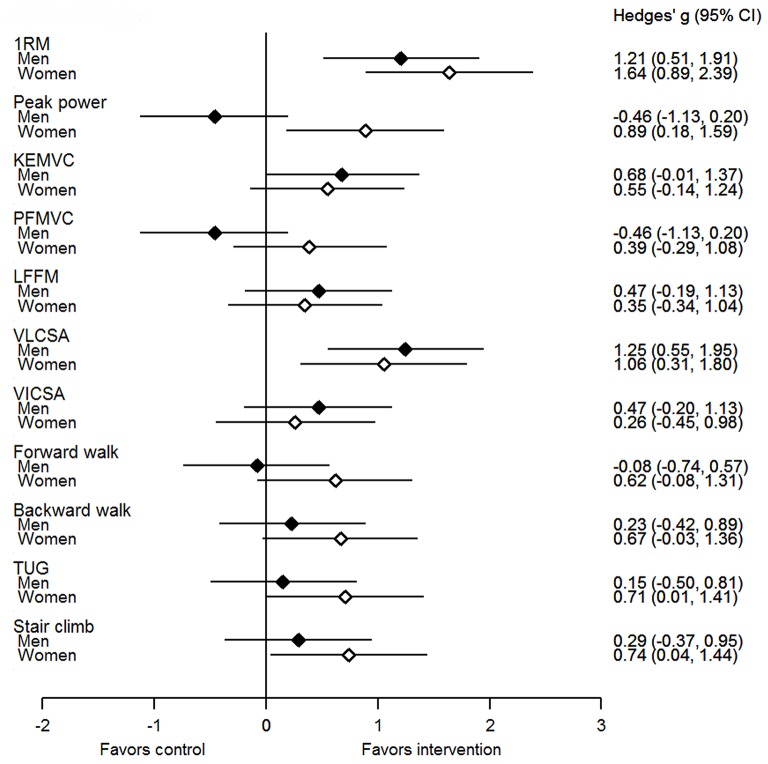
Hedges' g effect size (95% confidence intervals) for the unadjusted mean differences between intervention (men and women) and control groups. KEMVC, maximum isometric knee extension torque; PFMVC, maximum isometric plantarflexion torque; LFFM, leg fat-free mass; VLCSA, vastus lateralis cross-sectional area; VICSA, vastus intermedius cross-sectional area; TUG, Timed-Up-and-Go test.